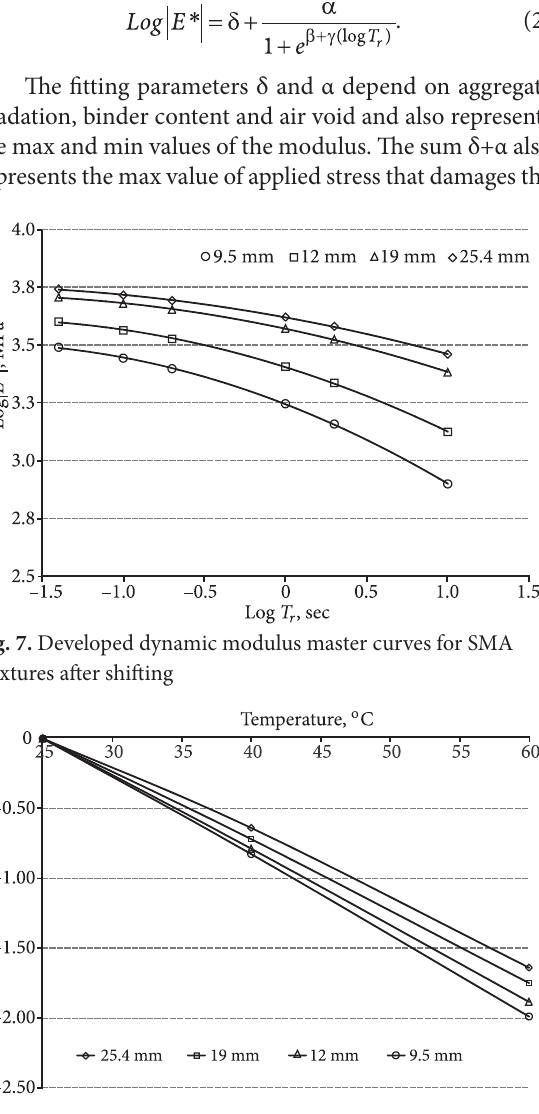
Fig. 6. Individual stiffness curves at each temperature before shifting